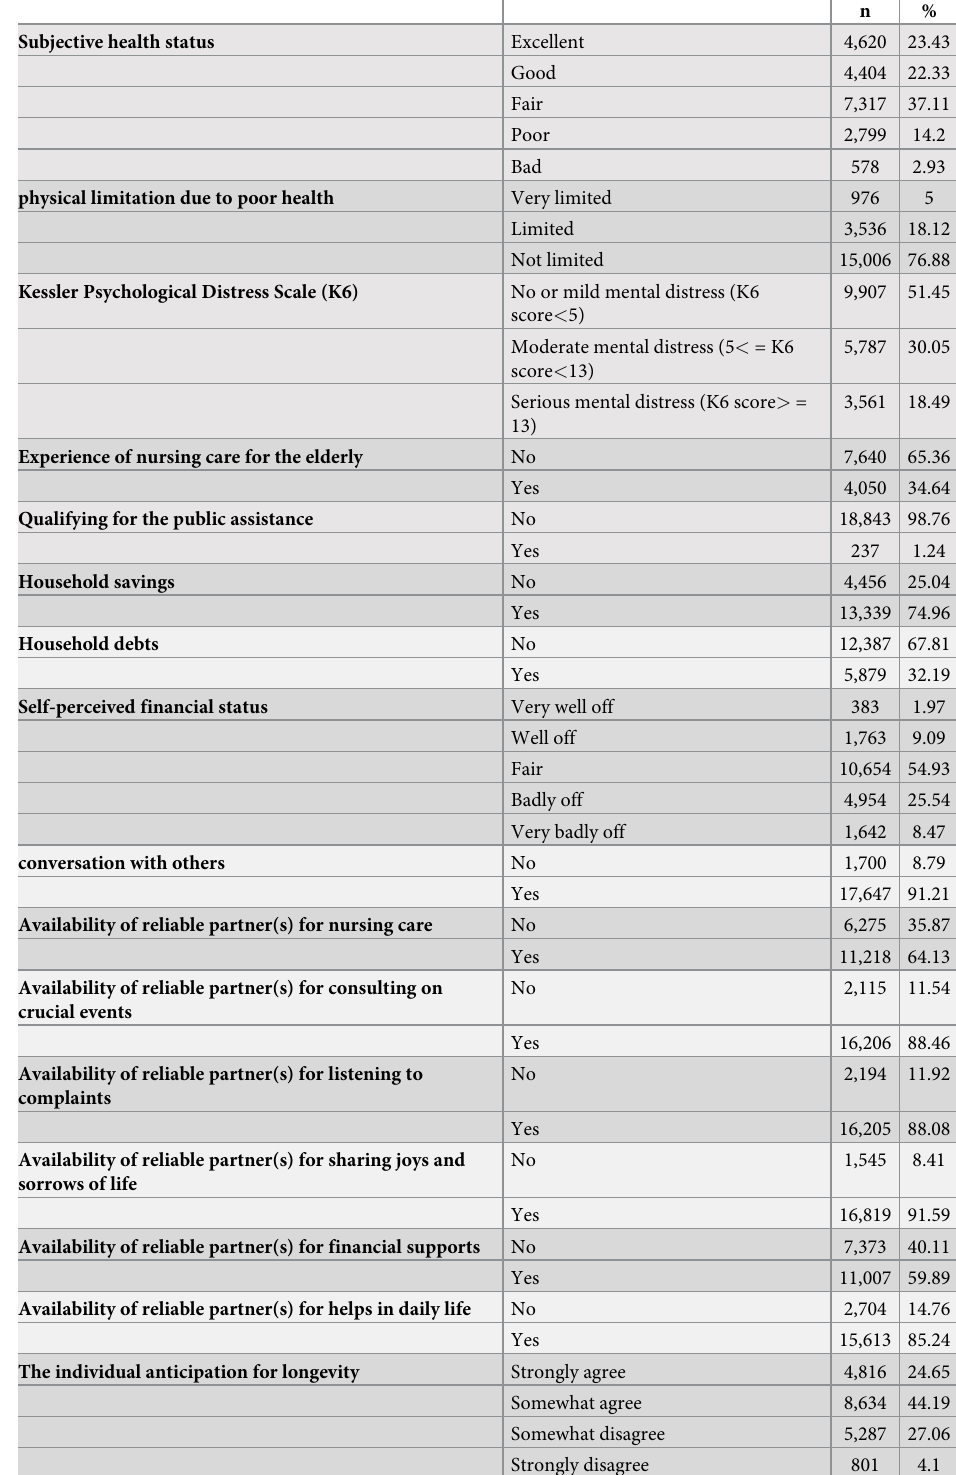
Table 2. Basic demographic characteristics of participants